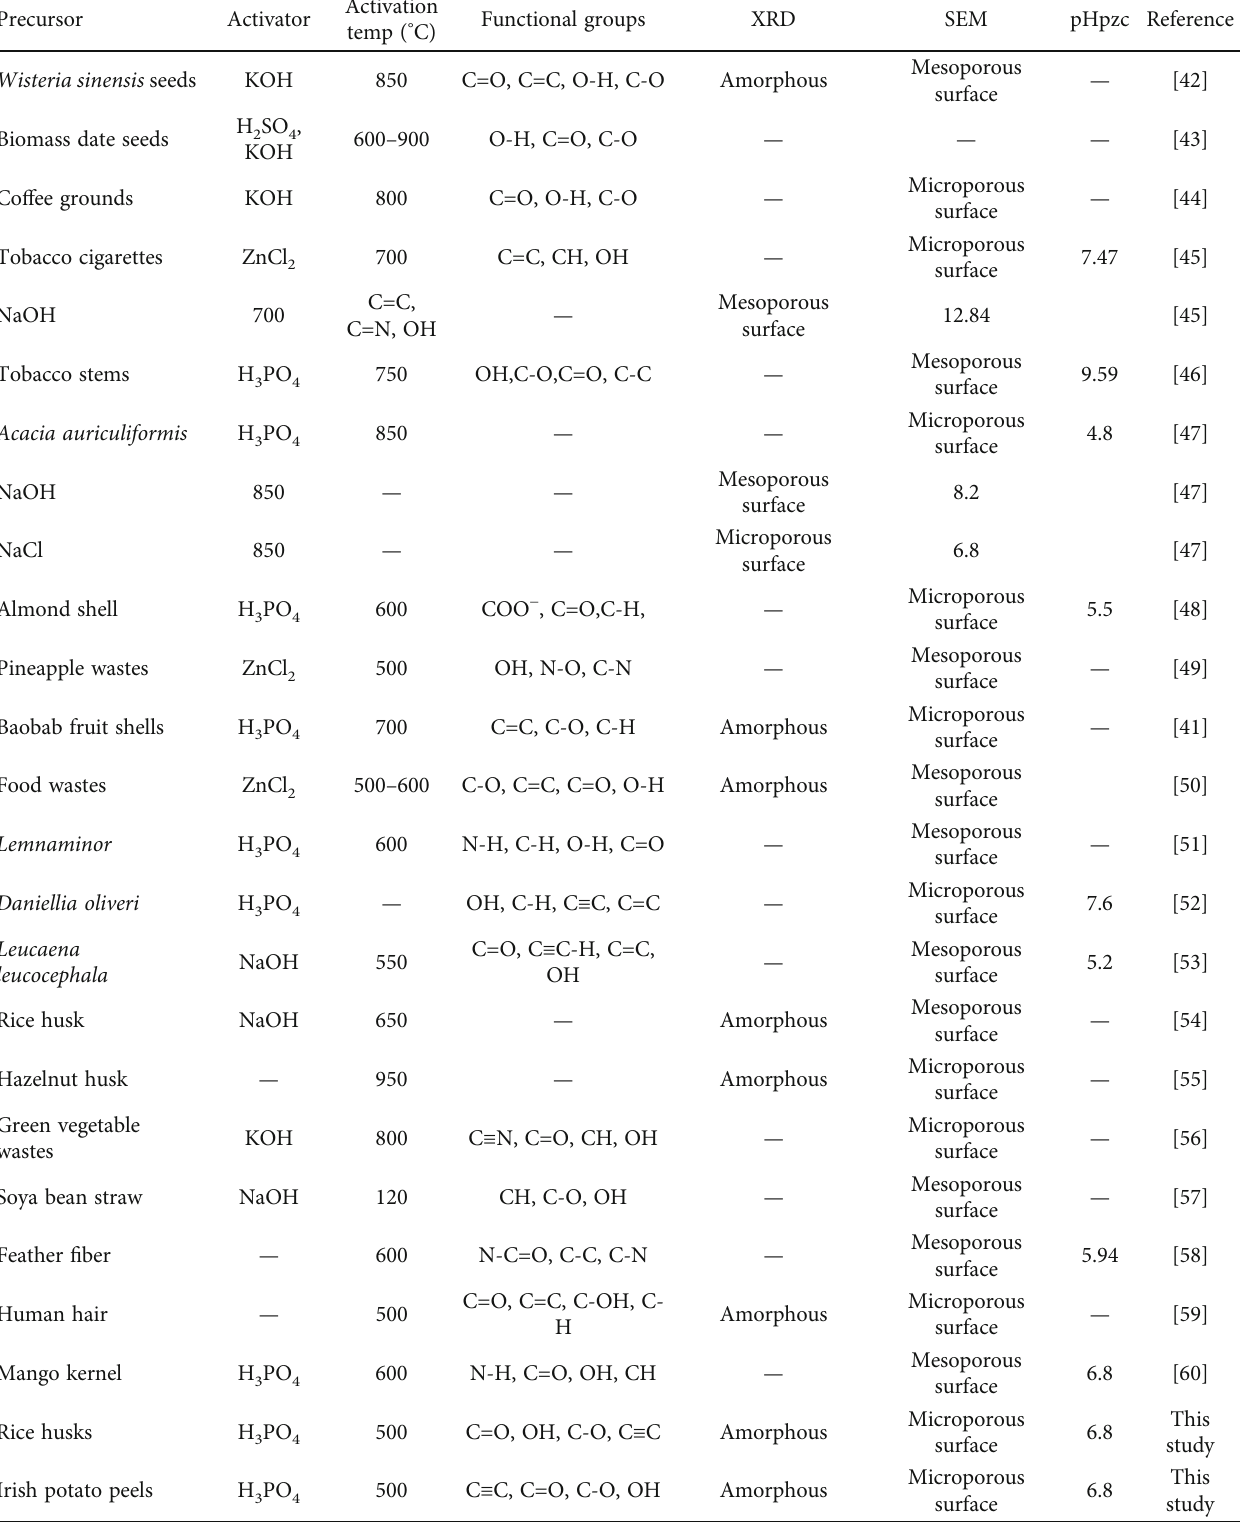
Table 4: A comparison of the characteristics of the activated carbons with other literature reported